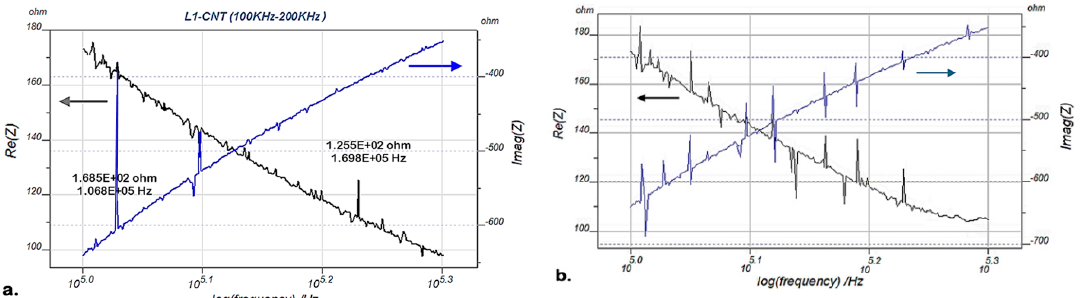
Figure 4. Real and imaginary EMI for the blade L 1 , frequency sweep at 100 Hz–100 kHz using IVIUM analyzer at 20 °C; ( a ) pristine blade and ( b ) damaged blade.